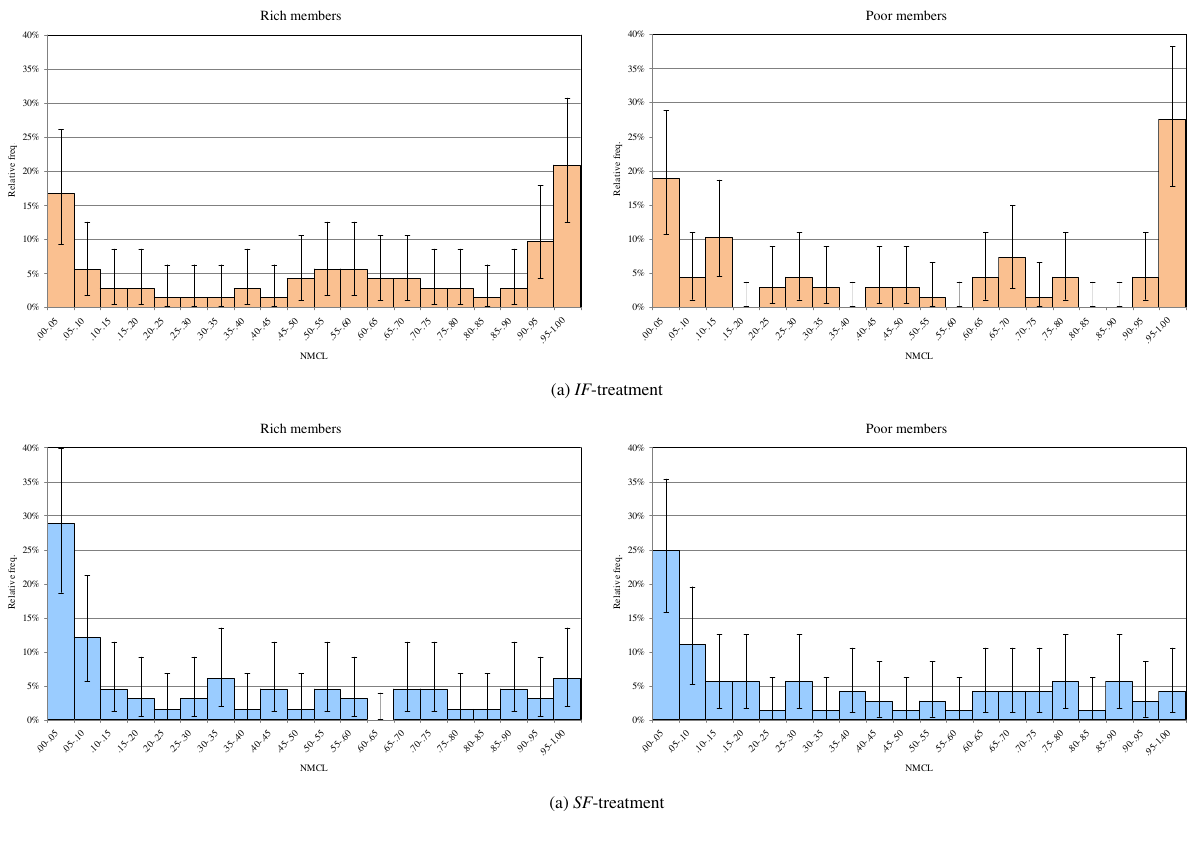
Figure 2 . Relative position of the observed MCL s within the corresponding randomly generated distribution, with 95% confidence intervals. Rich members Poor